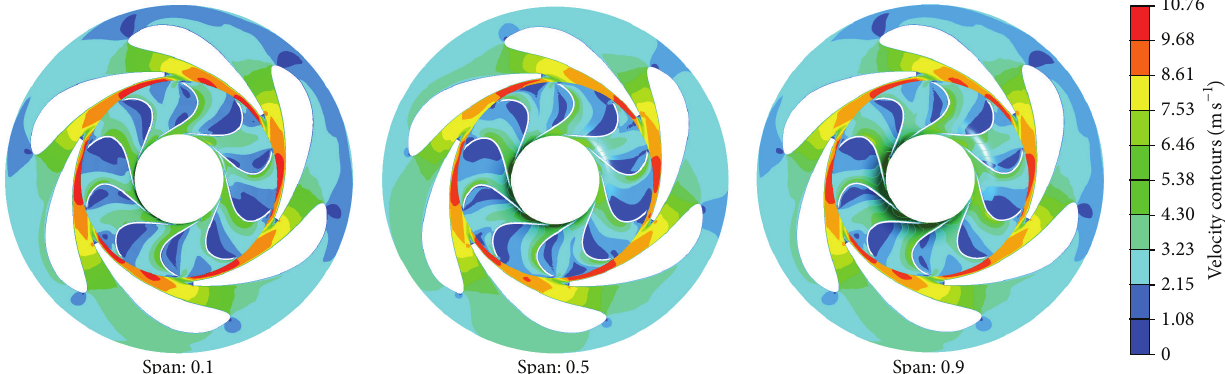
Figure 10: Velocity contours in distributor vanes and runner at three spans, for optimal point (BEP).